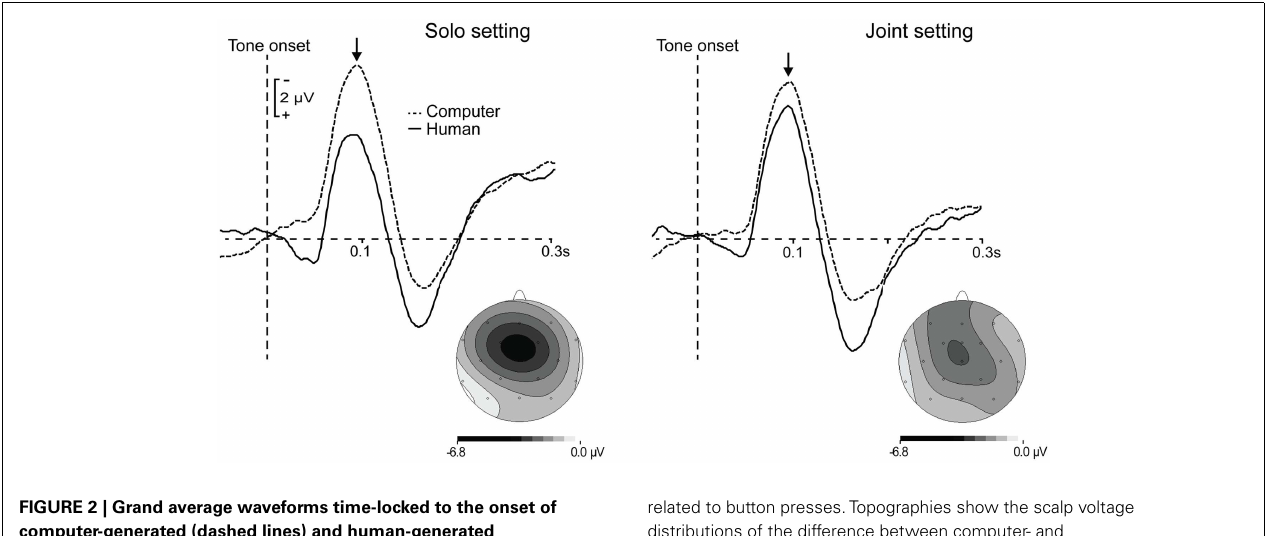
FIGURE 2 | Grand average waveforms time-locked to the onset of computer-generated (dashed lines) and human-generated (solid lines) tones in the solo and joint settings. ERP responses to human-generated tones were corrected for motor activity